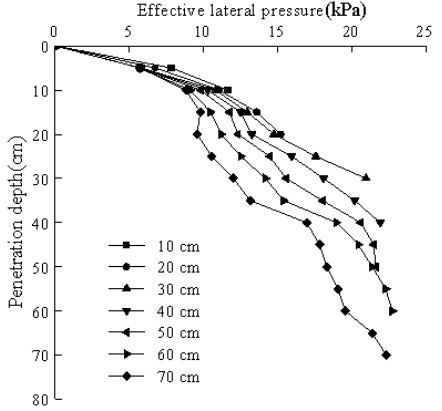
Figure 12. The relationship between the effective lateral pressure and the penetration depth at different pile pressing depths.